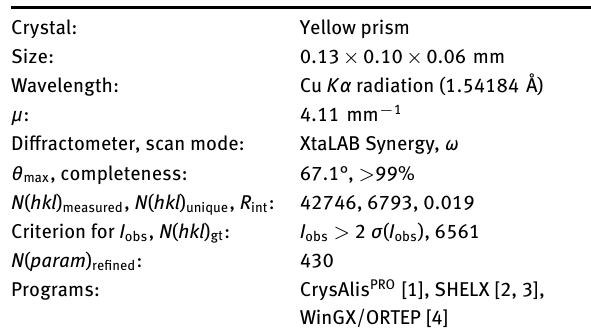
Table 1: Data collection and handling.